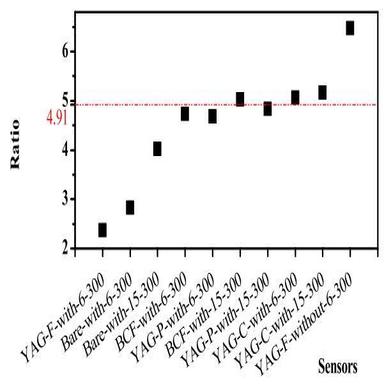
The ratio ofthe averagephotonnumber (n) over the average voltage inclinical based results.